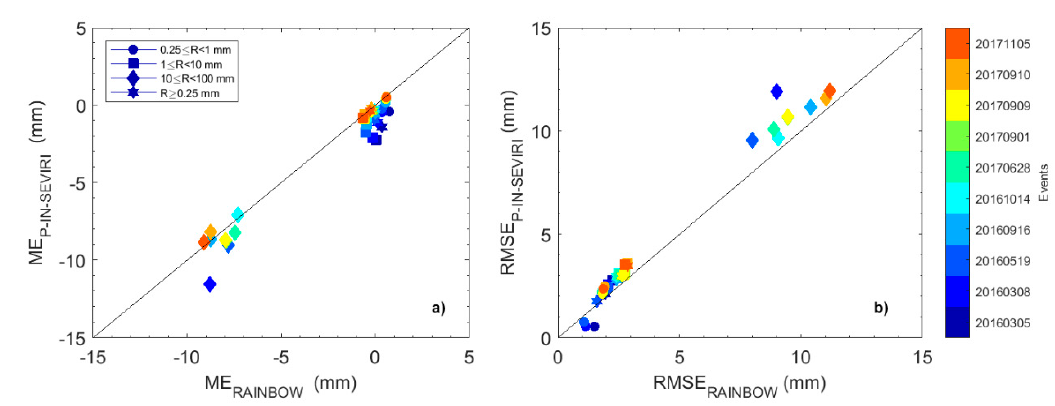
Figure 13. Comparison of ( a ) ME and ( b ) RMSE scores calculated for RAINBOW and P-IN-SEVIRI outputs with respect to the GRISO data (taken as reference) on a regular 0.25° × 0.25° grid for 10 case studies. A minimum cumulated rain threshold is set at 0.25 mm and three different intervals of cumulated rain are considered: light 0.25–1 mm, moderate 1–10 mm, and heavy 10–100 mm.